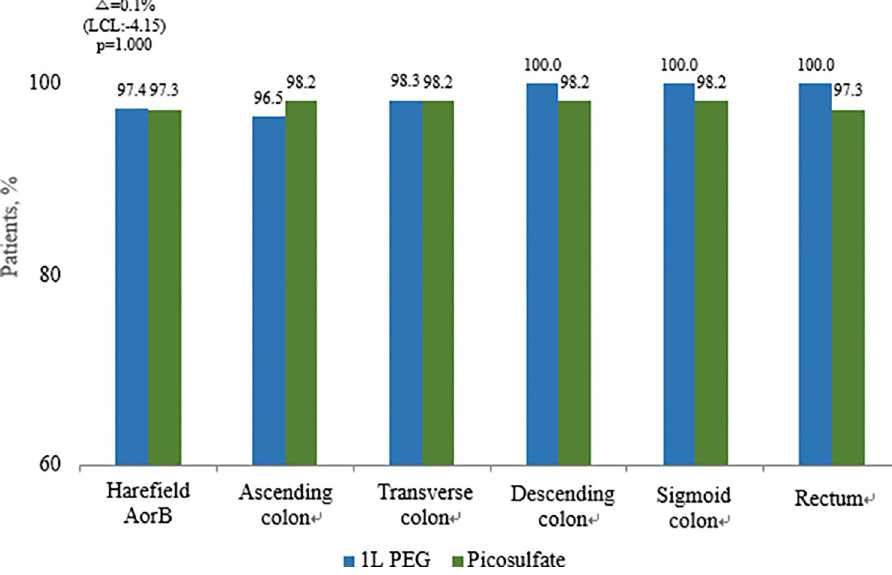
Fig 2. Efficacy of bowel cleansing using the Harefield Cleansing Scale, including overall and segment bowel cleansing success rate. Δ –Difference in efficiency between the 1 L PEG with ascorbic acid group and the PICO with magnesium citrate group; LCL- 97.5% one-sided lower confidence limit for the difference between treatments.